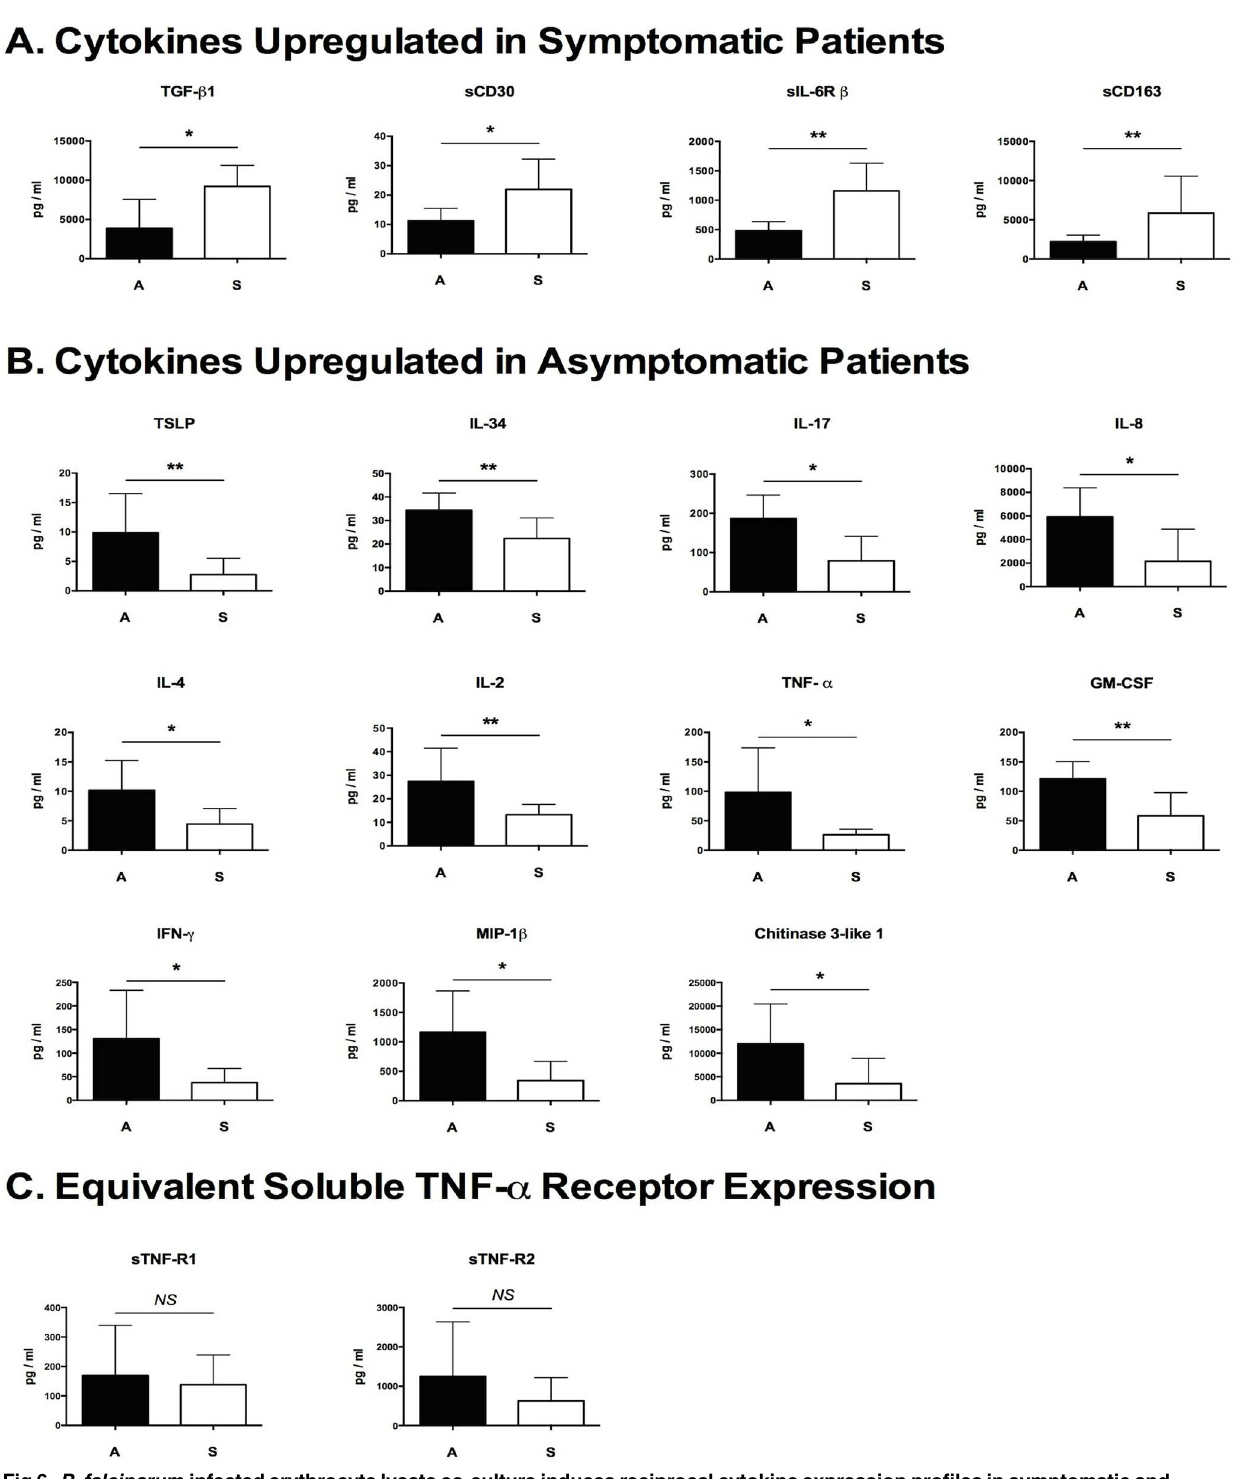
Fig 6. P . falciparum -infected erythrocytelysate co-culture induces reciprocal cytokine expression profiles in symptomatic and asymptomatic malaria patient PBMCs. PBMCs from symptomatic (n = 6) and asymptomatic (n = 9) malariapatients were co-culturedwith lysate from P . falciparum strain H1064 schizont infected erythrocytes at a schizont to effector cell ratio of 2:1 for 6 days and the resultingculture supernatant was assayed for cytokine concentration using multiplexanalysis. This revealeda set of 15 cytokines that were reciprocallyand differentially expressedin the patient groups. (A) one cytokine, a solublecytokine receptor, and two solubleCD markers were more highly